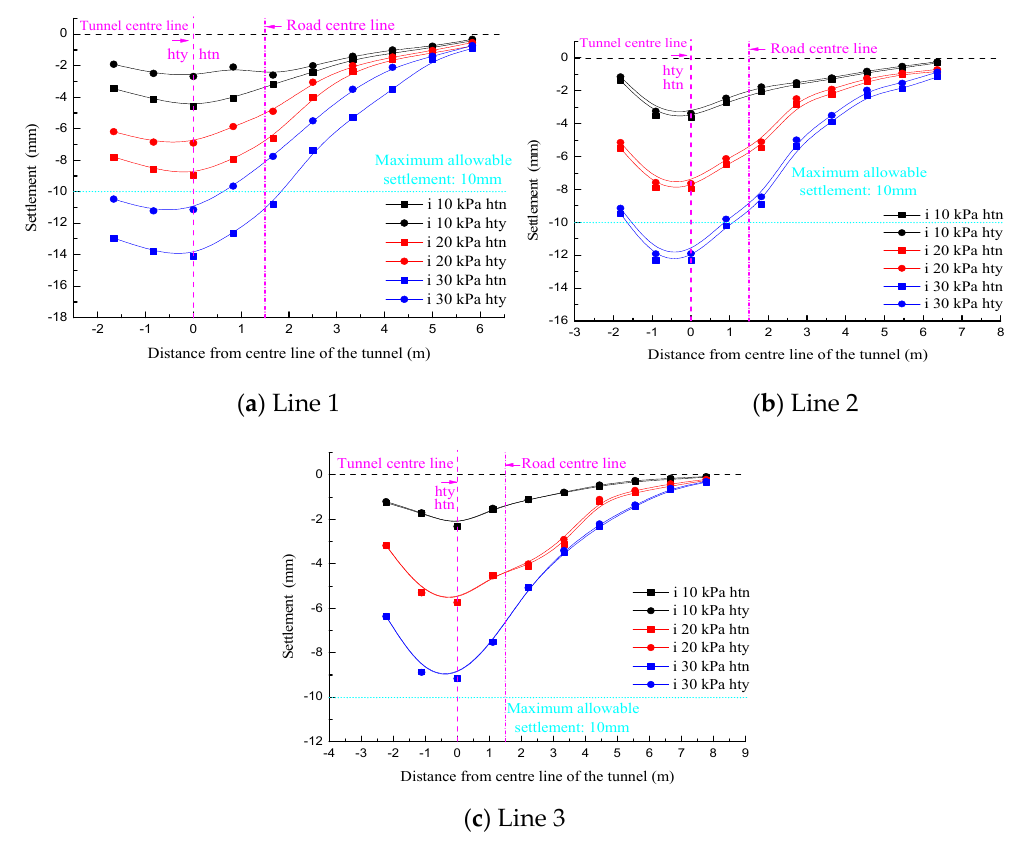
Figure 19. Longitudinal surface settlement of model I-I with D/W = 0.124.